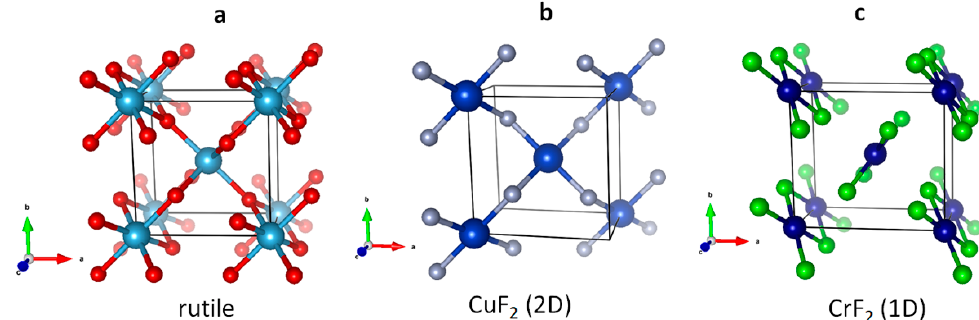
Figure 4. Crystal structure of rutile highlighting the edge- and corner-shared octahedra ( a ), rutile-derived two-dimensional (2D) CuF2- ( b ) and a hypothetical one-dimensional (1D) ribbon structure ( c ) achieved by octahedral elongation along two distinct octahedral directions.